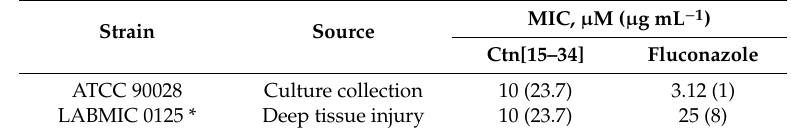
Table 1. Minimum inhibitory concentration (MIC) of Ctn[15–34] against Candida albicans